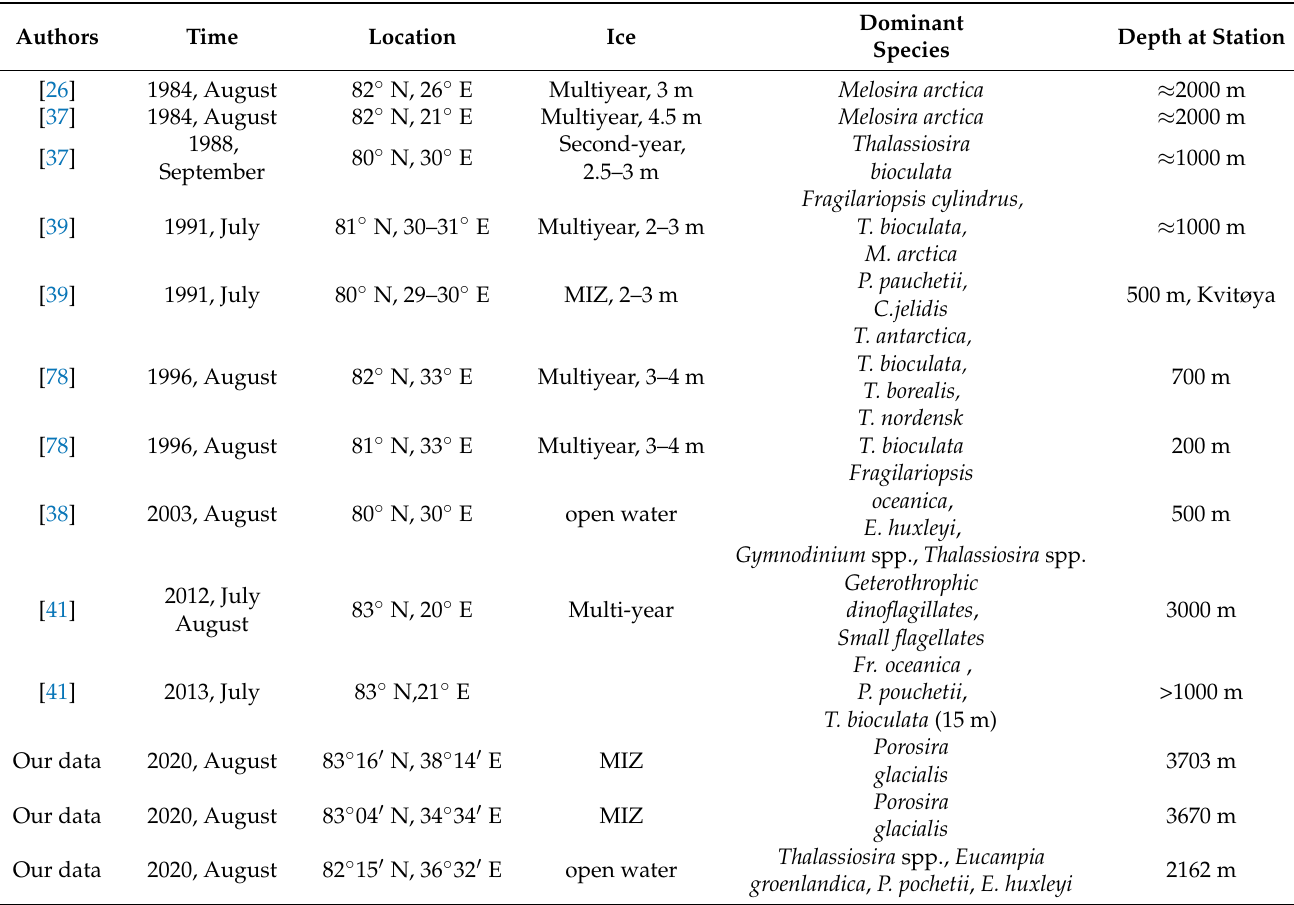
Table 6. Time and place of sampling, dominant species according to literature and own data in the Nansen Basin and the northern part of the Barents